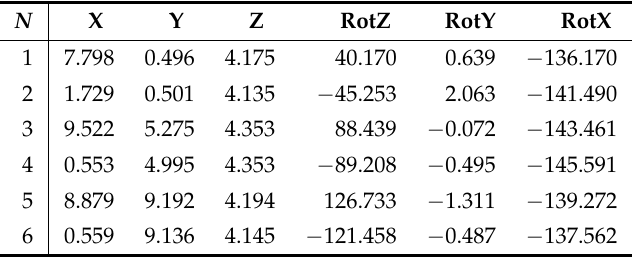
Table 1. Calibrated sensor positions in meters and orientations in degrees. The positions are in the global coordinate system. N corresponds to the sensor number. N X